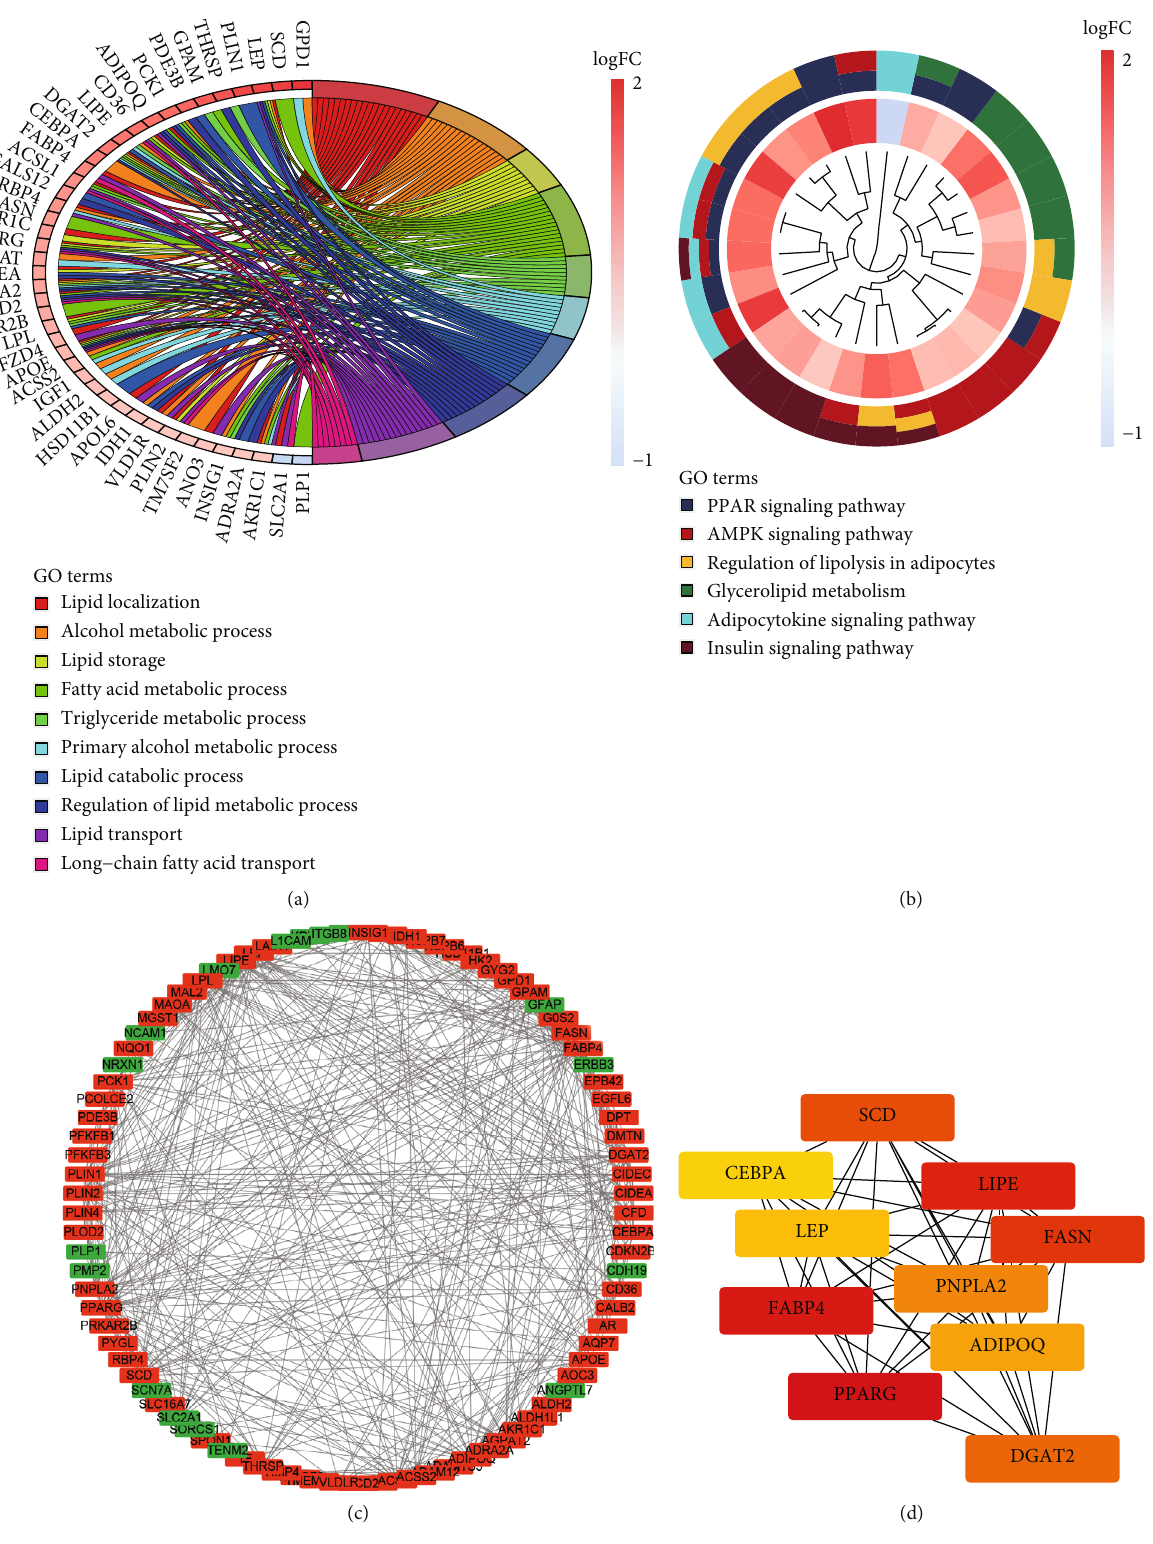
Figure 5: Di ff erential expression analysis, function enrichment analysis, and hub gene selection. (a) A circular plot for GO enrichment analysis of the DEGs in two adipogenesis subgroups. (b) A clustering circular plot for KEGG analysis of the DEGs in two adipogenesis subgroups. (c) Protein-protein interaction network construction and analysis of di ff erentially expressed genes. Red nodes represent upregulated genes, and green nodes represent downregulated genes. (d) Top 10 candidate genes with maximal clique centrality, including PPARG, FABP4, LIPE, FASN, SCD, DGAT2, PNPLA2, ADIPOQ, LEP, and